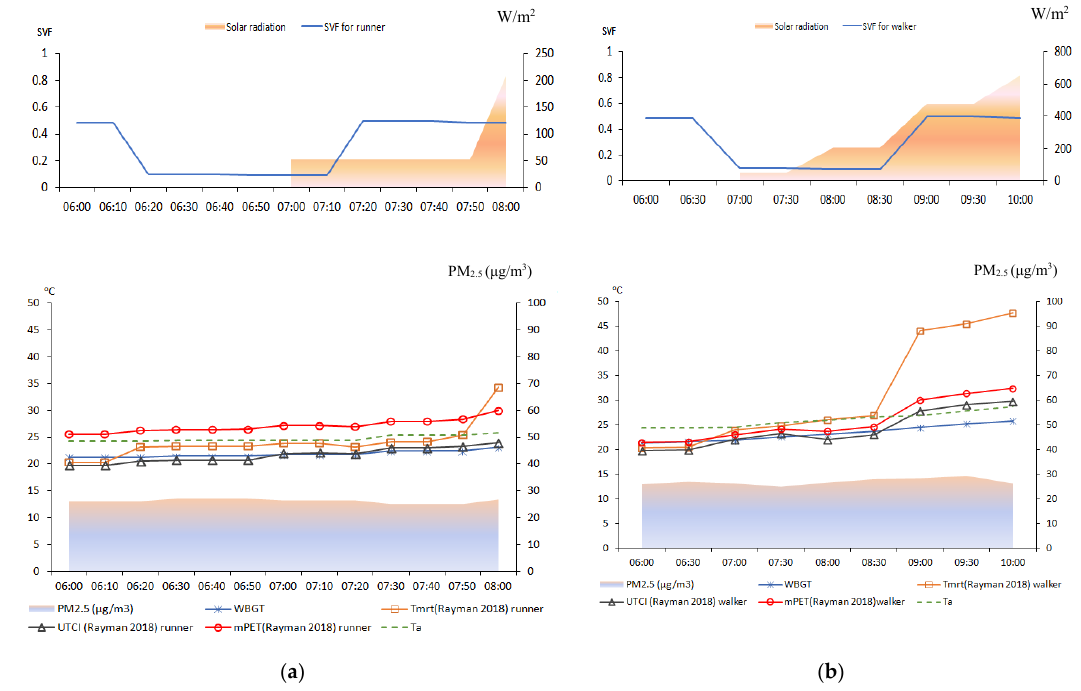
Figure 9. Autumn running event thermal and environmental conditions for runners ( a ) and walkers ( b ).